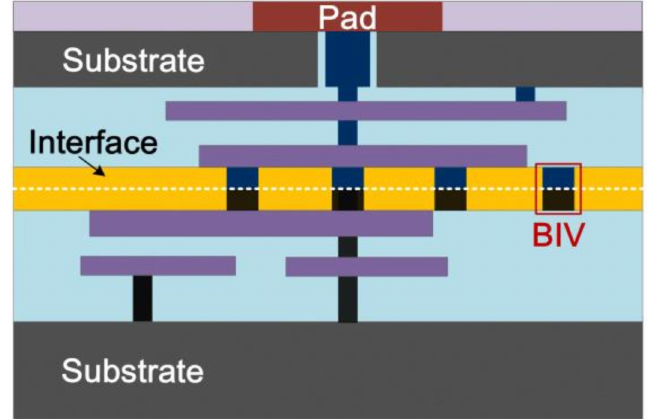
Figure 1. Cross-sectional view of 3D NAND Flash test chip.